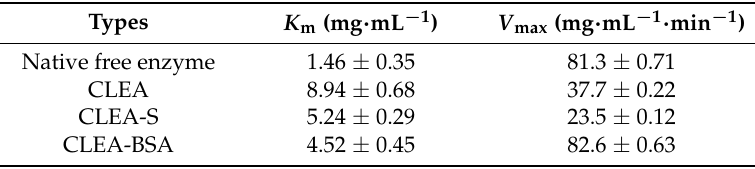
Table 1. Kinetic parameters of native and immobilized enzyme at 45 ◦